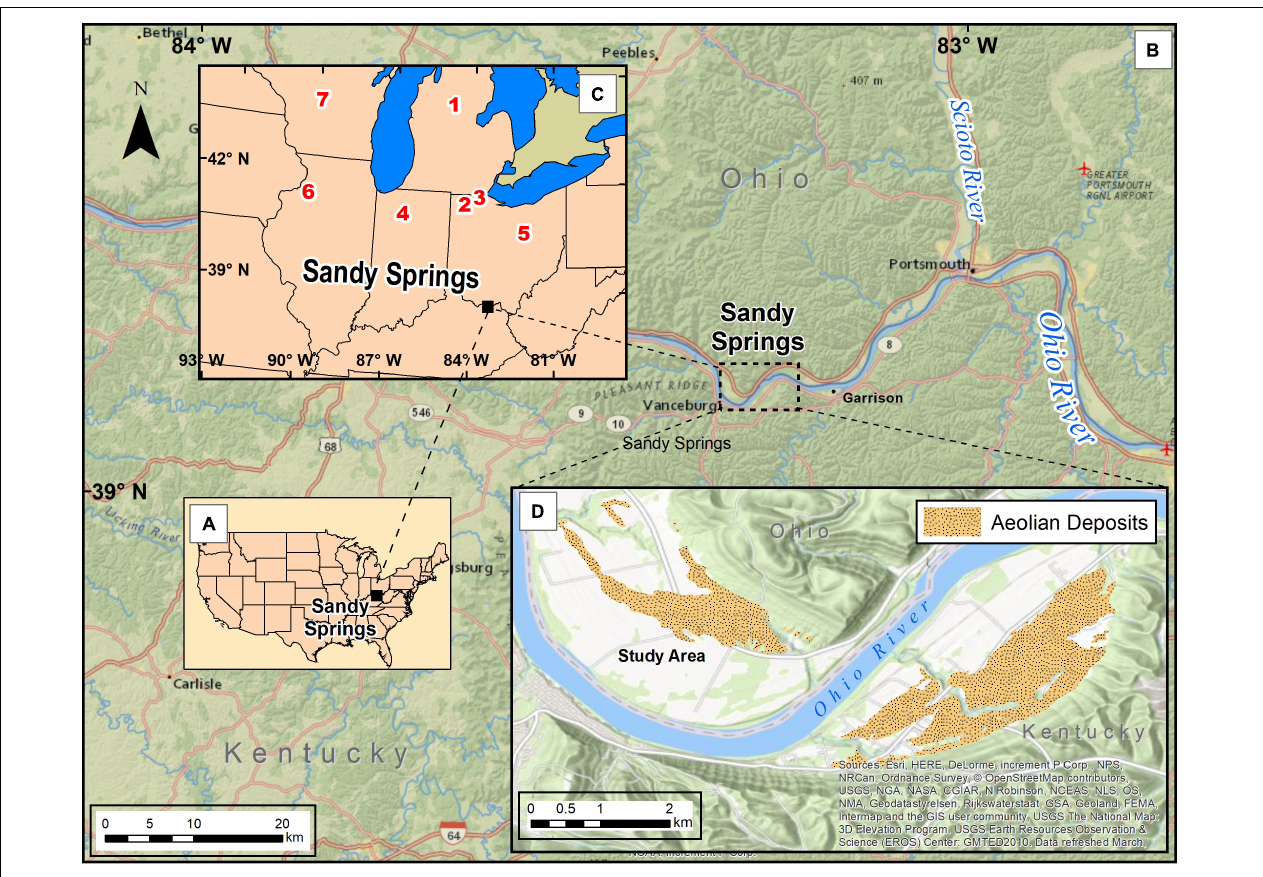
FIGURE 1 | Location of Sandy Springs (A) in continental United States and (B) showing position along the upper Ohio River in relation to the Scioto River, and (C) with reference to additional sites mentioned in the text (1 = Arbogast et al., 2015; 2 = Blockland, 2013; 3 = Campbell et al., 2011; 4 = Kilibarda and Blockland, 2011; 5 = Lutz et al., 2007; 6 = Miao et al., 2010; 7 = Rawling et al., 2008). (D) Combined distribution of sediments interpreted as aeolian in past geologic and pedologic literature (Chaplin and Mason, 1967; Morris and Pierce, 1967; USDA-NRCS, 2017). This study focuses on areas north of the Ohio River as illustrated (D) .